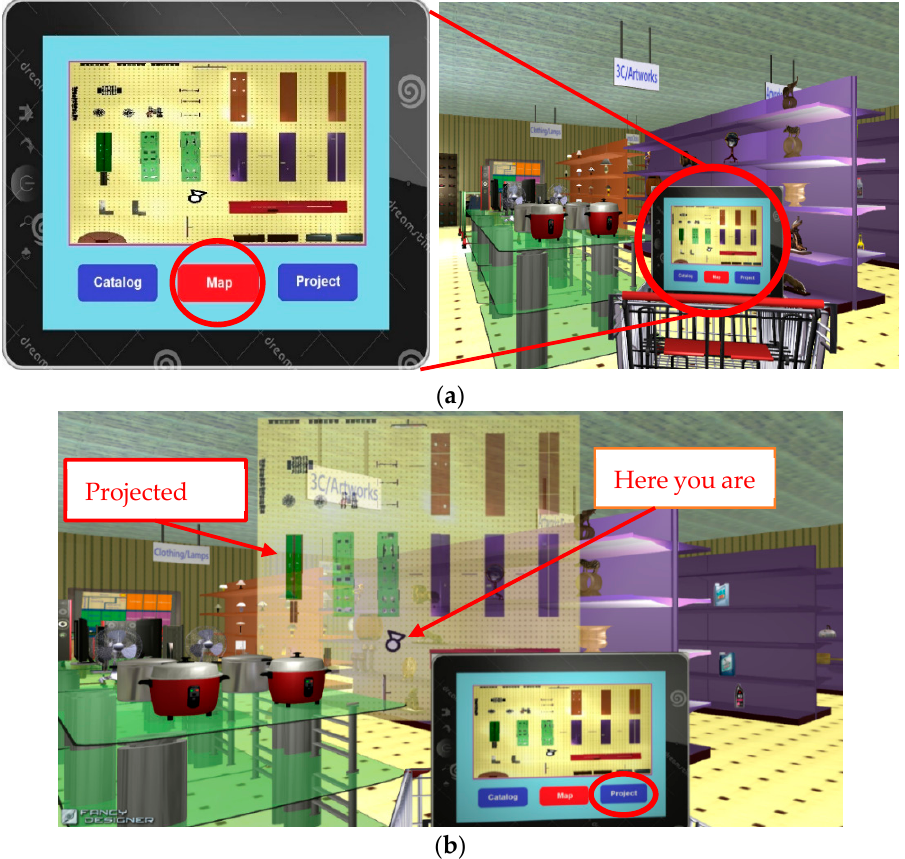
Figure 4. Map-based navigation system: ( a ) consumers click the “Map” button on the tablet computer, and the navigation map appears on the screen; ( b ) if the map is not clear, the customer can click the “Project” button to generate an enlarged projected map in front; customers can determine their position as shown on the map and move to the desired section.